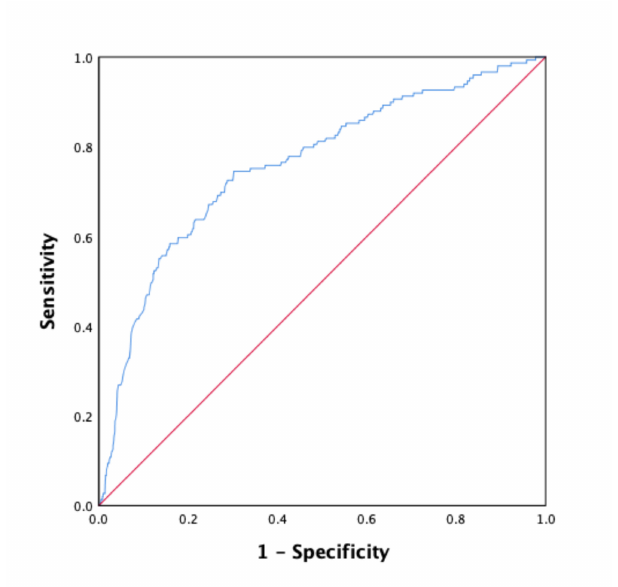
Figure 2. ROC curve demonstrating the predictive performance of LF / HF ratio for the onset of new AF during AMI: AUC = 0.73 (0.69–0.78; p < 0.001); optimal threshold: 1.735; sensitivity = 0.698; specificity =